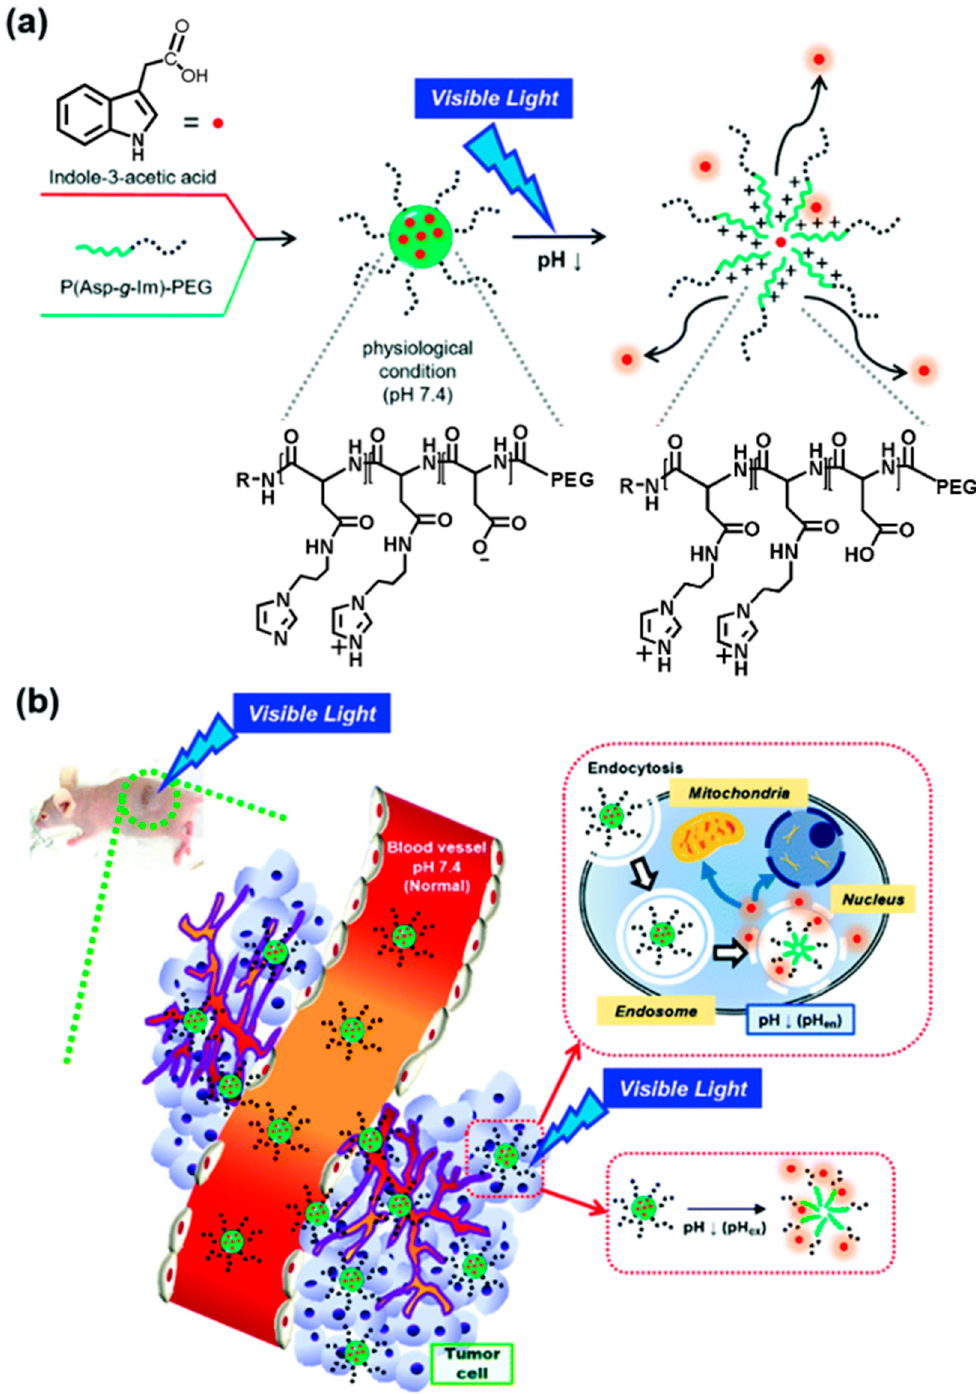
Figure 3. Schematic concepts for an improved photodynamic therapeutic effect using IAA-loaded micelles (ILMs) : ( a ) hypothetical mechanism for the behavior of ILMs and ( b ) proposed performance of ILMs in vivo. Reproduced with permission from Sim, T.; Lim, C.; Hoang, N.H.; Kim, J.E.; Lee,